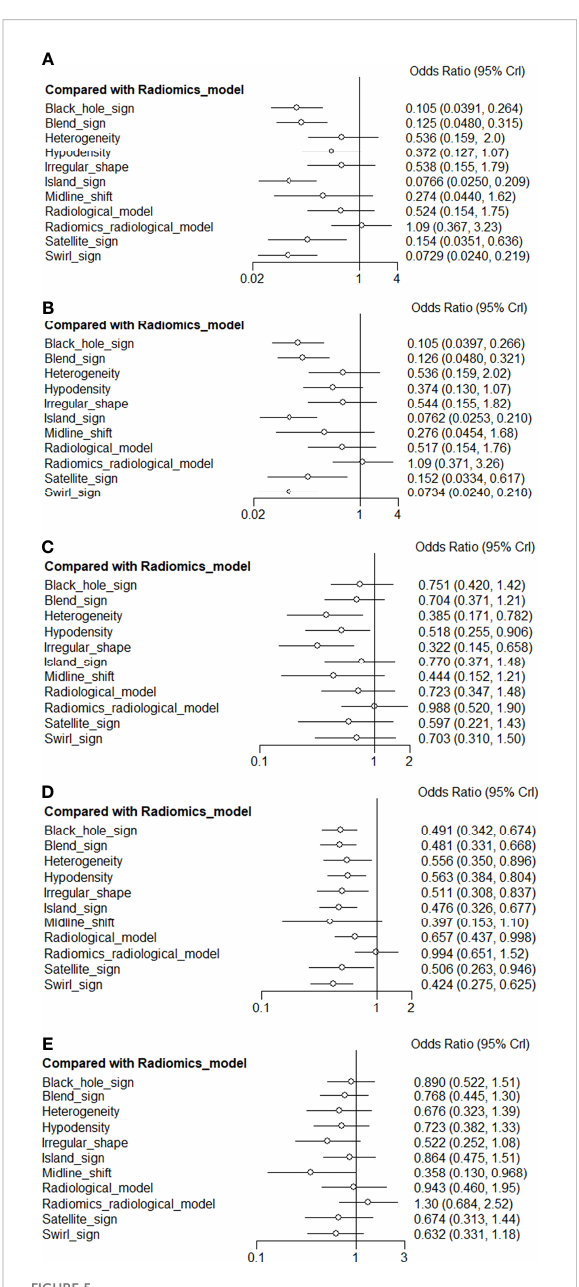
(Figure 6A), which is de fi ned as an area that has relatively low attenuation adjacent to an area with high attenuation, showed 39.3% sensitivity and 95.5% speci fi city for predicting hematoma growth. The black hole sign (Figure 6B), which represents a low- density area within a hematoma with high density, is reported to have sensitivity of 31.9% and speci fi city of 94.1% (30). One of the